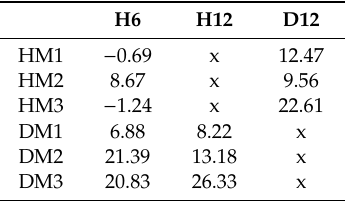
Table 4. Relative (%) di ff erences in genetic correlations between indicated variables derived from measurements and estimates by the HM1–HM3 and DM1–DM3 models.